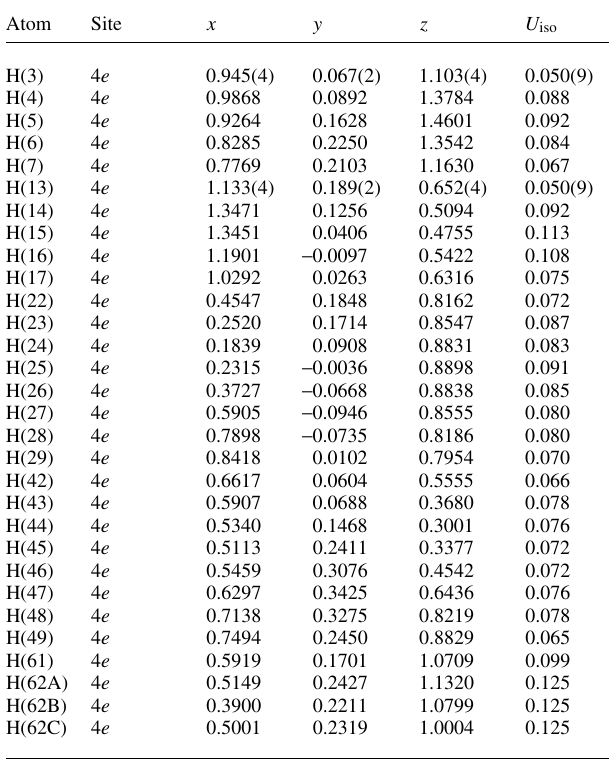
Table 2. Atomic coordinates and displacement parameters (in Å 2 ) .